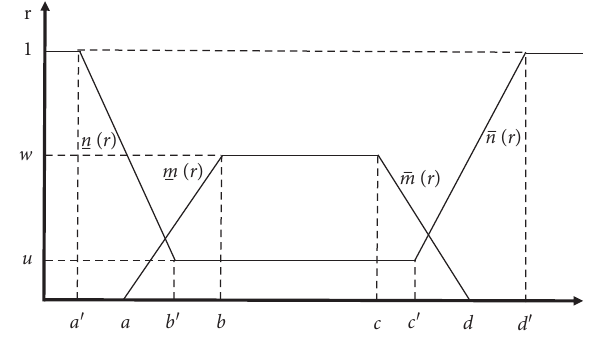
Figure 4: Representation of a TraIFN by Definition